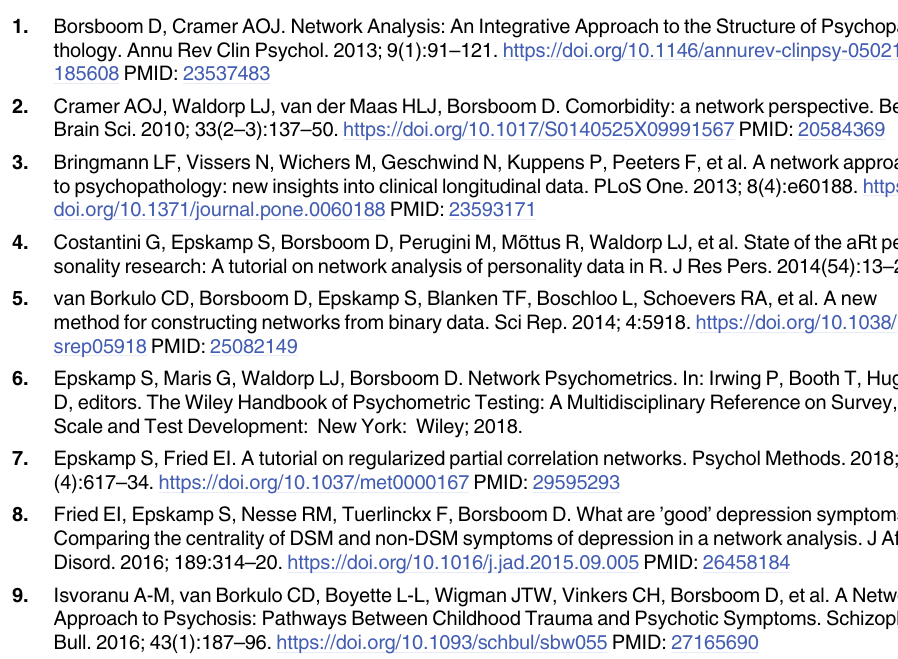
S7 Fig. Fixed linear time slopes of BPDSI subscales. Slopes were calculated by taking the mean of posterior model distributions and represent change in the subscale score per month. See S3 Table for node legend. S8 Fig. Fixed linear time slopes of BPDSI items. Slopes were calculated by taking the mean of posterior model distributions and represent change in the item score per month. Items are labeled in the following way: (number of symptom scale. item